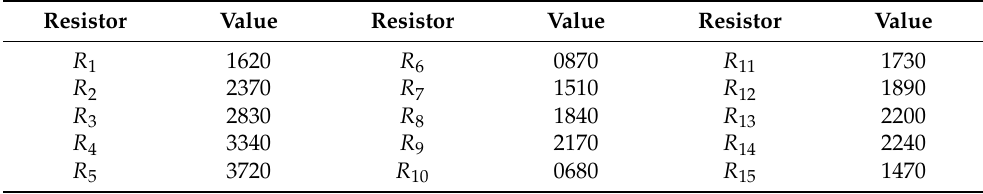
Table 6. Resistor values for Xalapa map.